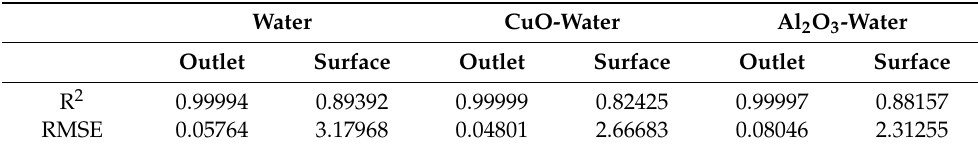
Table 9. Validation of simulation by comparison of predicted and measured